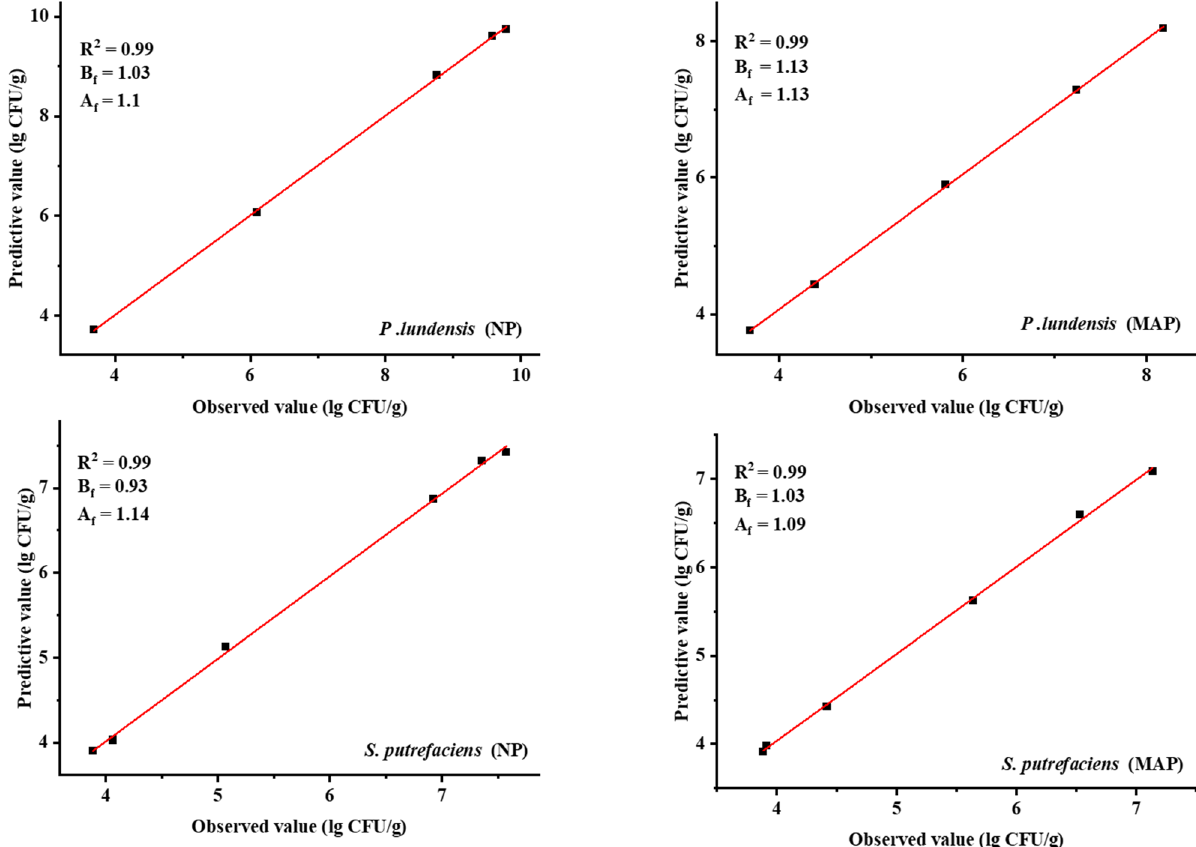
Figure 6. Comparison of the observed and predicted numbers of dominant spoilage bacteria in chilled chicken samples stored at 2 °C under different packaging methods.